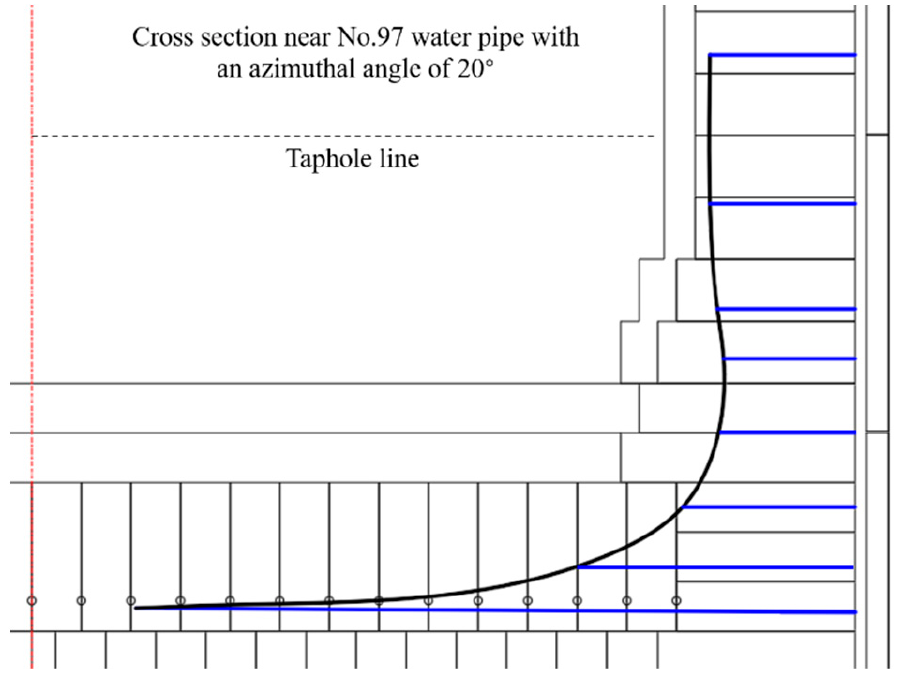
Figure 7. Measured erosion profile on the hearth cross section near No. 97 water pipe of the WISCO No. 1 BF.